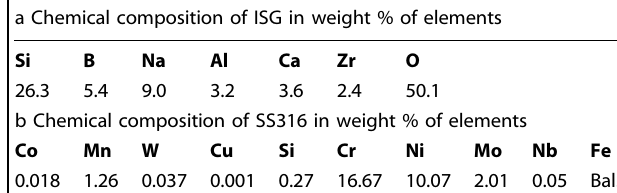
Table 4. Chemical composition of ISG and SS316 samples used in this